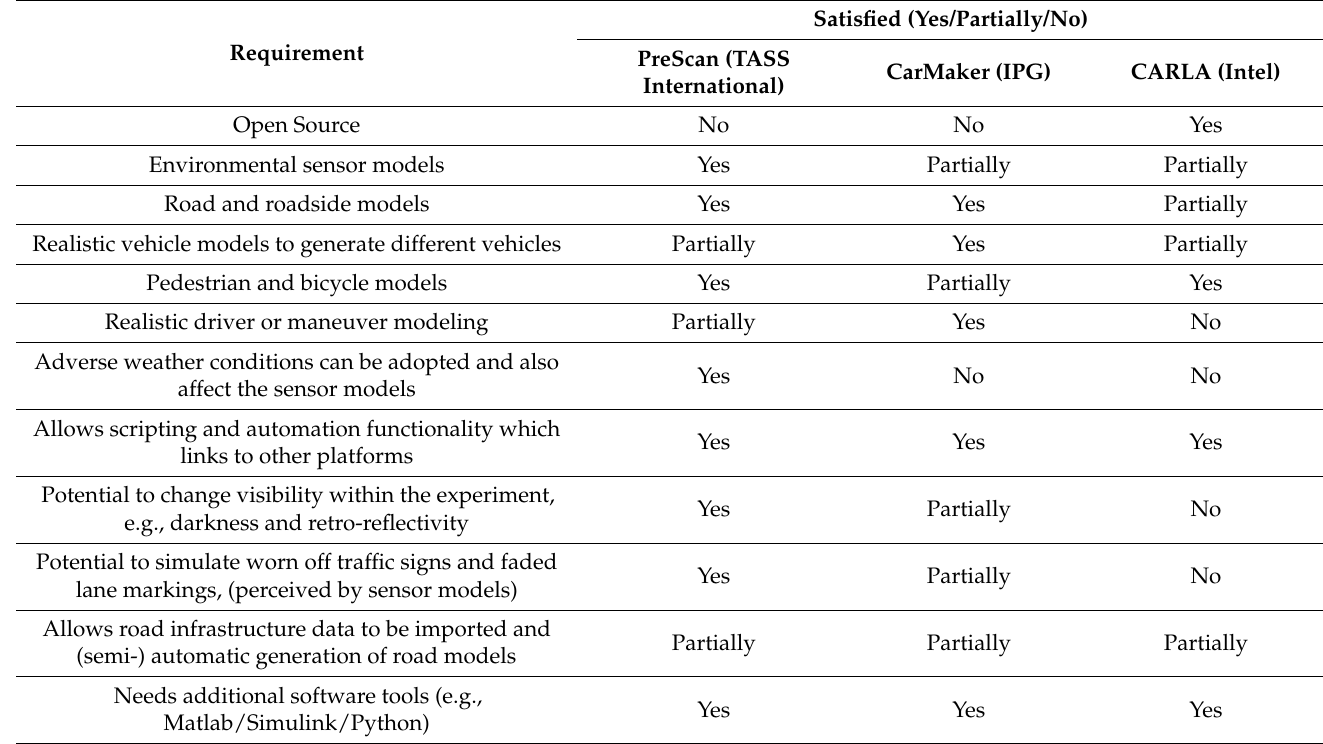
Table 1. Criteria for the selection of the appropriate sub-microscopic simulation tool (adapted from